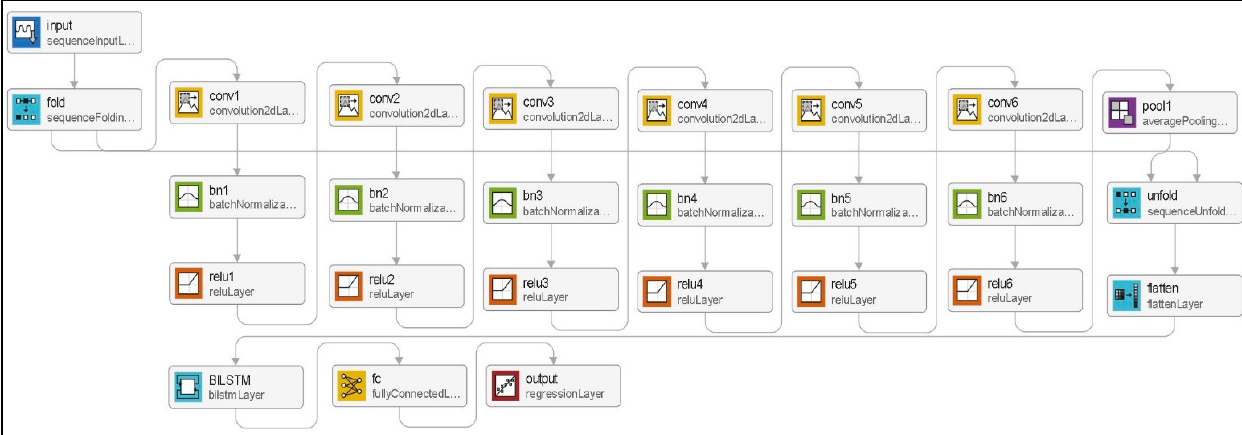
Figure 2. The components of the BestDAG architecture, obtained based on the designed research methodology.